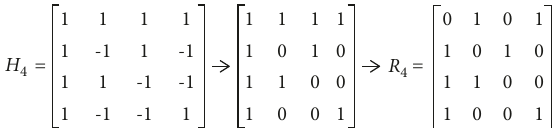
Figure 2: An example of standard Hadamard matrix H transforming into R 4 k 0